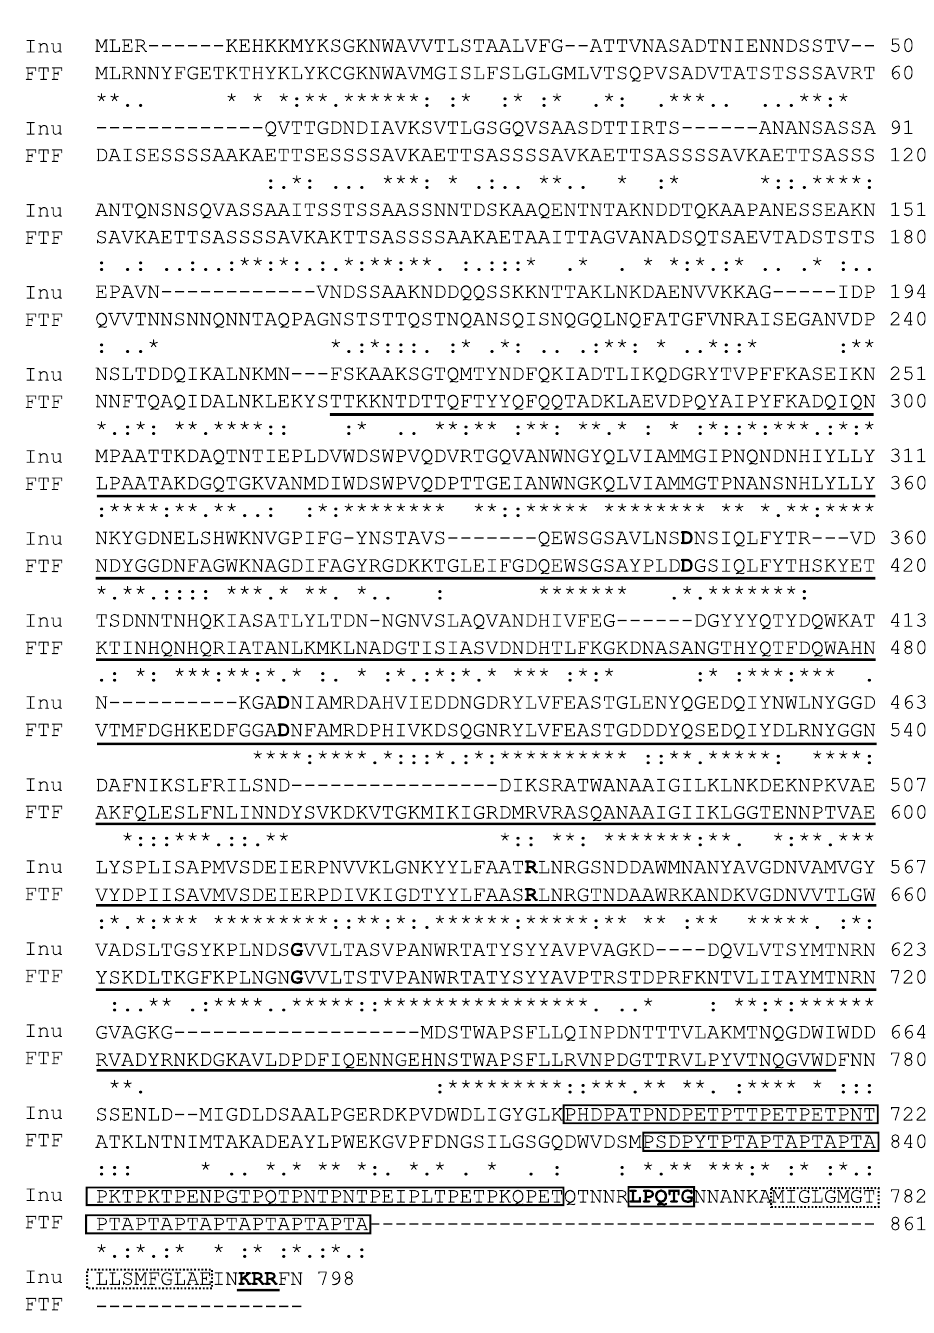
Figure 6. Alignment of fructansucrase (FTF) from L. plantarum DKL3 with inulosucrase (Inu) from L. reuteri 121 (AAN05575.1) 93 . The domains have been marked according to Van Hijum et al., 2002, the core region of GH68 with a solid line below the sequence (residues 257–777), key amino acids residues (numbers in reference to FTF) D406, D501, R634, and G676 with bold font, and PXX motifs by a box across the sequence (residues 823–861). Additionally, the reference sequence contained the LPXTG motif (denoted by a bold font and thick box across the sequence), a hydrophobic domain (dotted box across the sequence), and positively charged KRR residues (bold and underlined). The alignment was generated using MEGA X (https:// www. megas oftwa re.